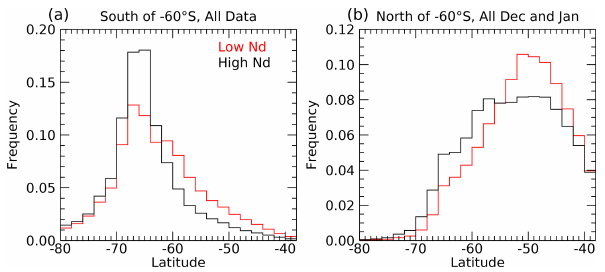
Figure 4. Distributions of the latitudes crossed by the 5d back tra- jectories for the low- (red) and high- N d (black) cloud